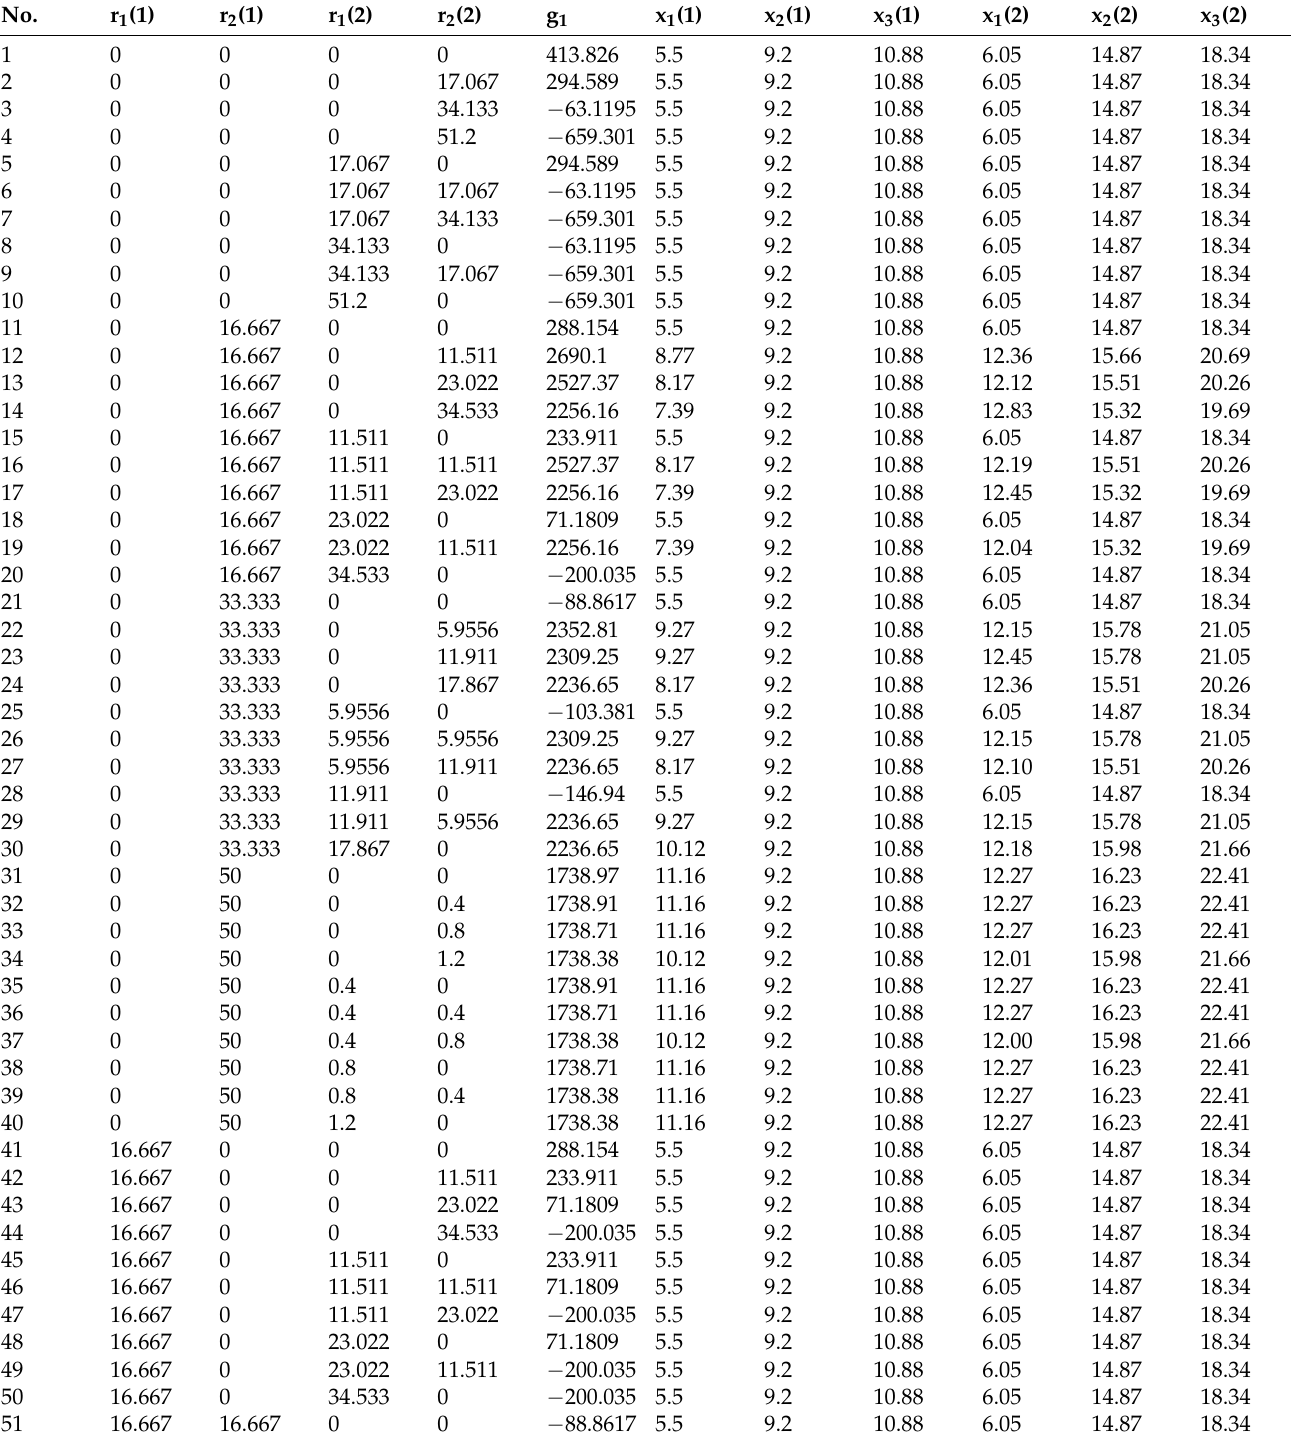
Table A1. Strategies of the first influence agent under fixed strategies of the Principal and the second influence agent: r 1 (1) = 0, r 2 (1) = 16.0(6), r 1 (2) = 11.5(1), r 2 (2) = 11.5(1), v 2 (1) = 11.111, v 2 (2) = 7.67407. Opinions of the basic